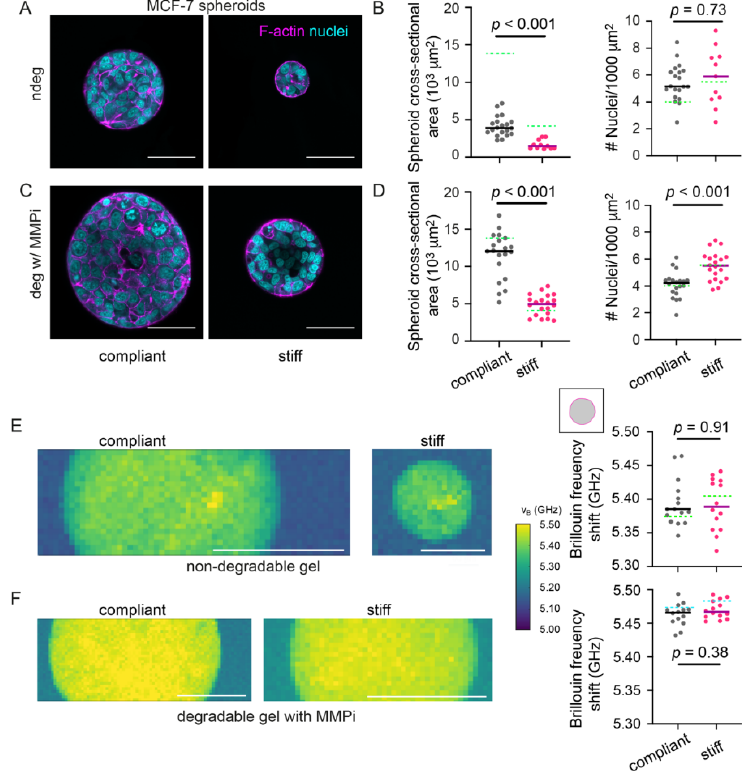
Figure 3. Blocking hydrogel degradation causes similar Brillouin frequency shifts between spheroids in compliant and stiff hydrogels. ( A ) Representative confocal microscopy images of MCF-7 spheroids grown in non-degradable compliant and stiff hydrogels. Spheroid cultures were stained for F-actin and nuclei using Phalloidin-TRITC and DAPI respectively. ( B ) Cross-sectional area and number density of cells per unit area of MCF-7 spheroids in compliant and stiff non-degradable gels. n = 10–20 spheroids each. ( C ) Representative confocal microscopy images of MCF-7 spheroids formed in a compliant and stiff degradable gel treated with 20 µM MMPi ( D ) Cross-sectional area and number density of cells per unit area of MCF-7 spheroids grown in compliant and stiff degradable gels treated with MMPi. n = 20 spheroids each. ( E ) Representative Brillouin maps of MCF-7 spheroids formed in a compliant and stiff non-degradable gel. Right: Scatter plot showing Brillouin frequency shifts for MCF-7 spheroids in compliant and stiff non-degradable gels. n = 14–15 spheroids each. Solid lines indicate medians. ( F ) Representative Brillouin maps of MCF-7 spheroids formed in a compliant and stiff degradable gel treated with MMPi. Right: Scatter plots showing Brillouin frequency shifts for MCF-7 spheroids in compliant and stiff degradable gels treated with MMPi. n = 14 spheroids each. Solid lines indicate medians. Dotted green and turquoise lines indicate medians of MCF-7 spheroids in ( B , E ) degradable gels or in ( D , F ) degradable gels treated with DMSO (vehicle control), respectively. A Mann–Whitney test was done for statistical analysis. p -values are given. All spheroids were analyzed after 14 days of culture. All scale bars correspond to 50 µm.